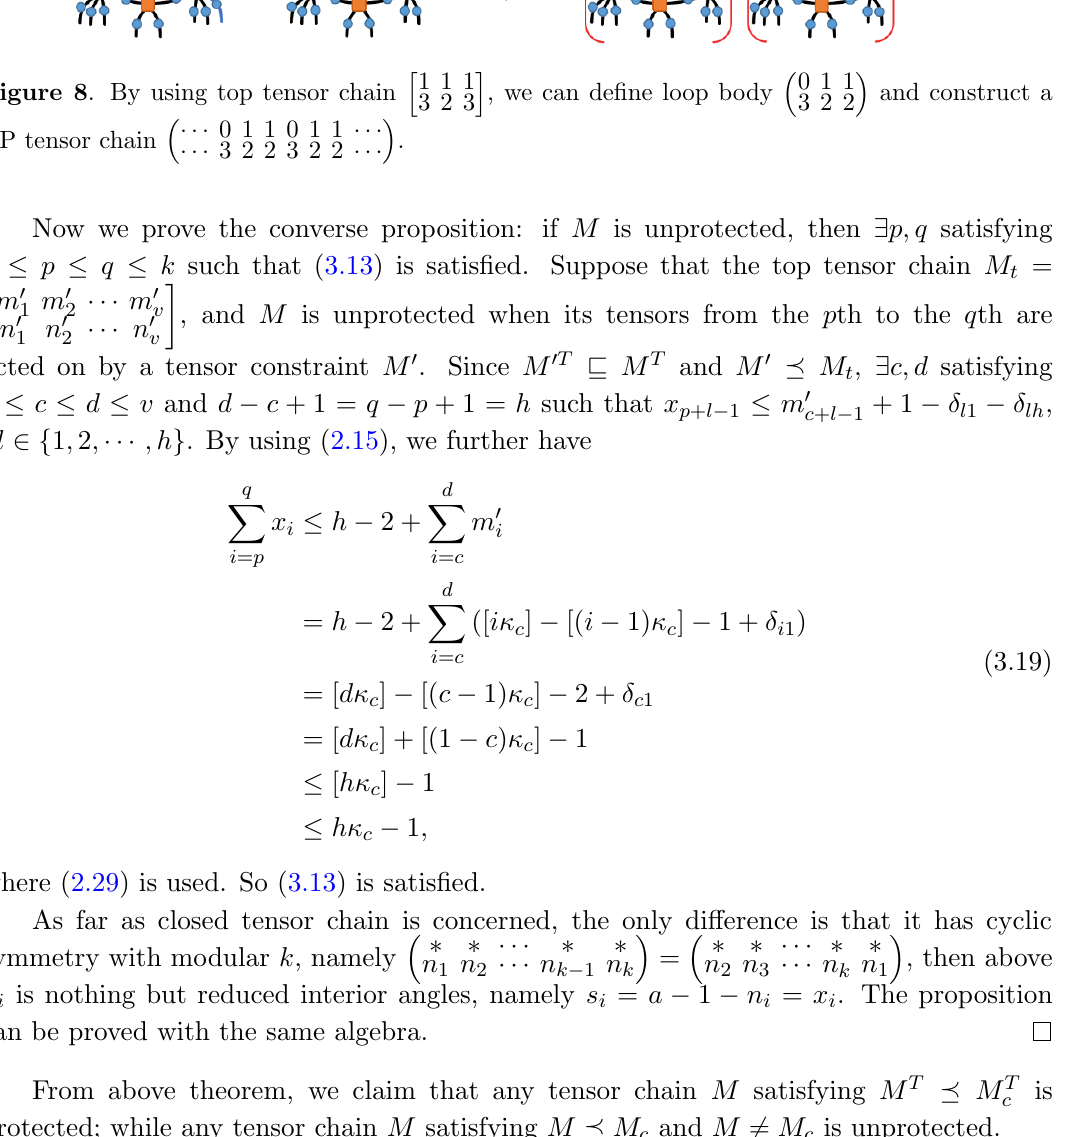
(cid:16) 0 1 1 (cid:17) and construct a 3 2 2